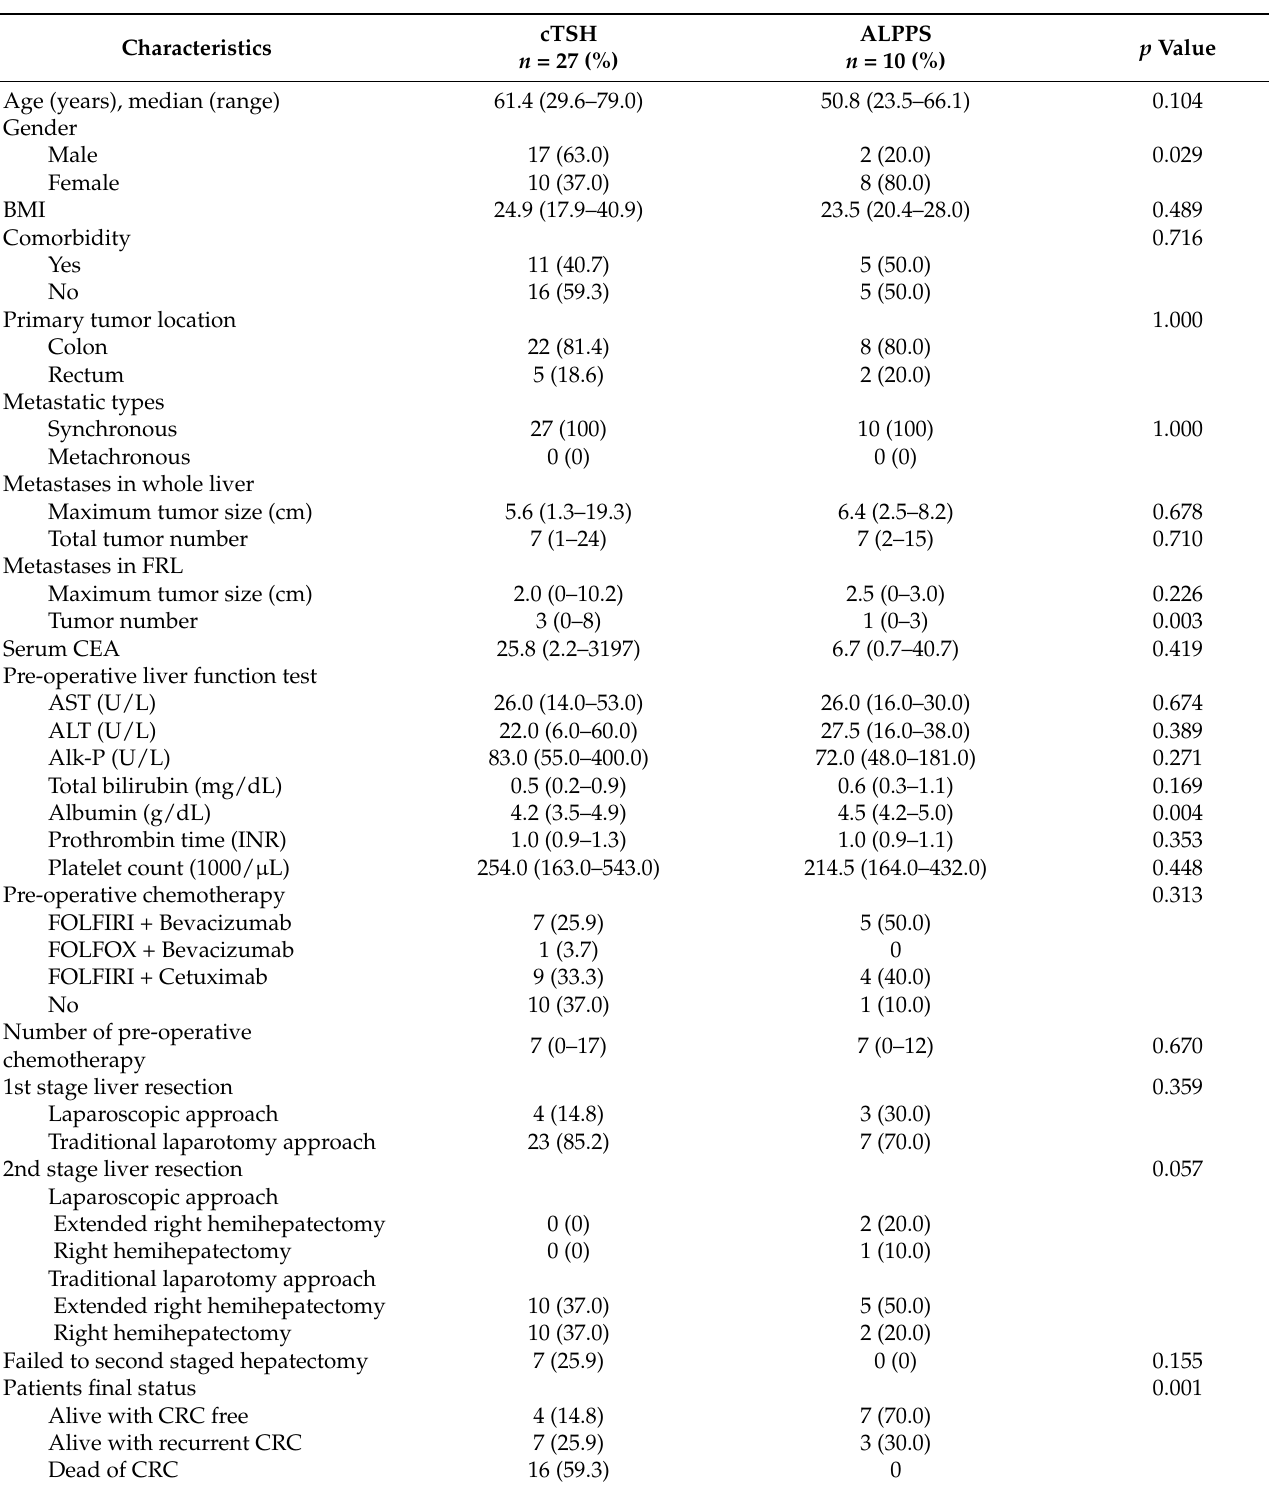
Table 1. Clinicopathologic characteristics of patients undergoing staged hepatectomy for colorectal cancer liver